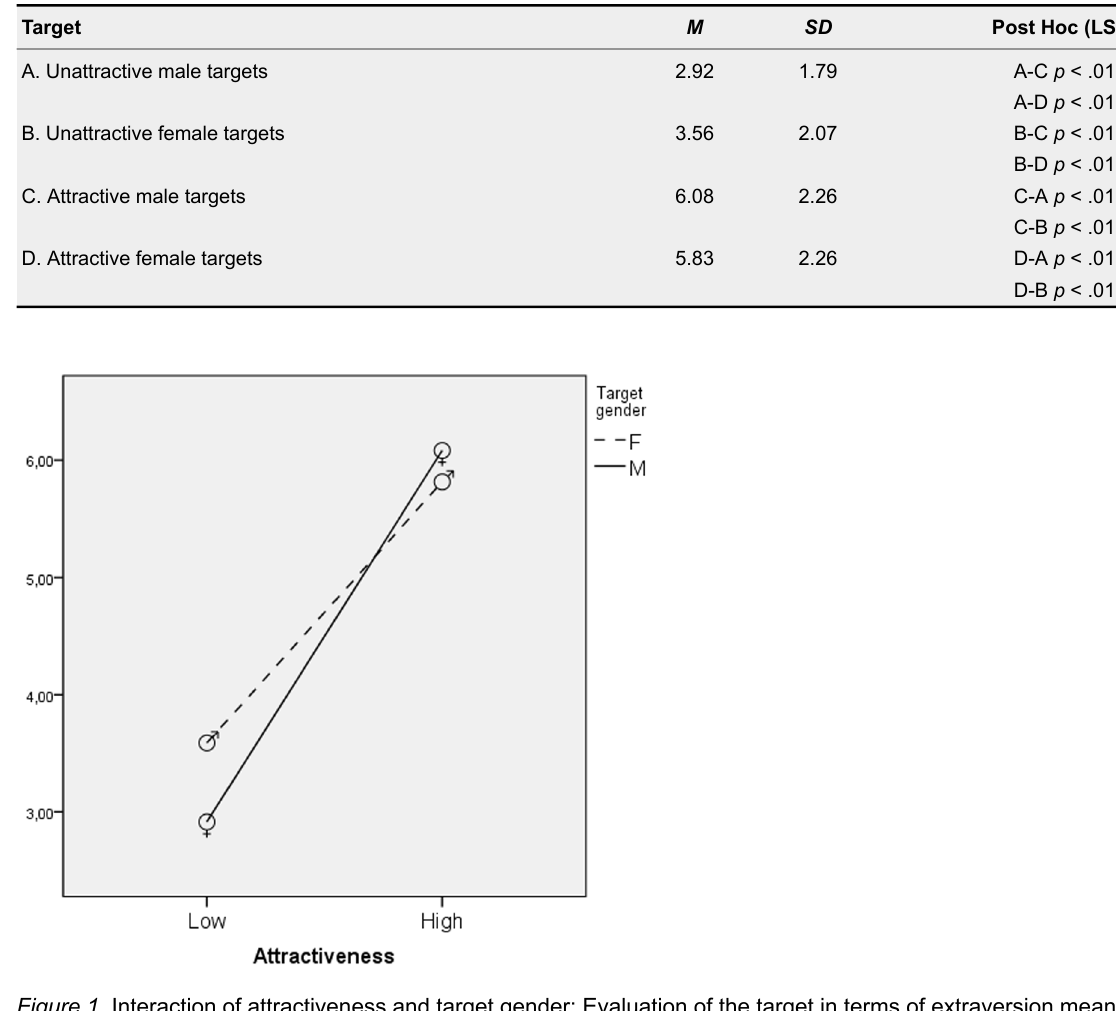
Perceived extraversion: Simple-effects comparisons for the interaction of attractiveness and target gender.